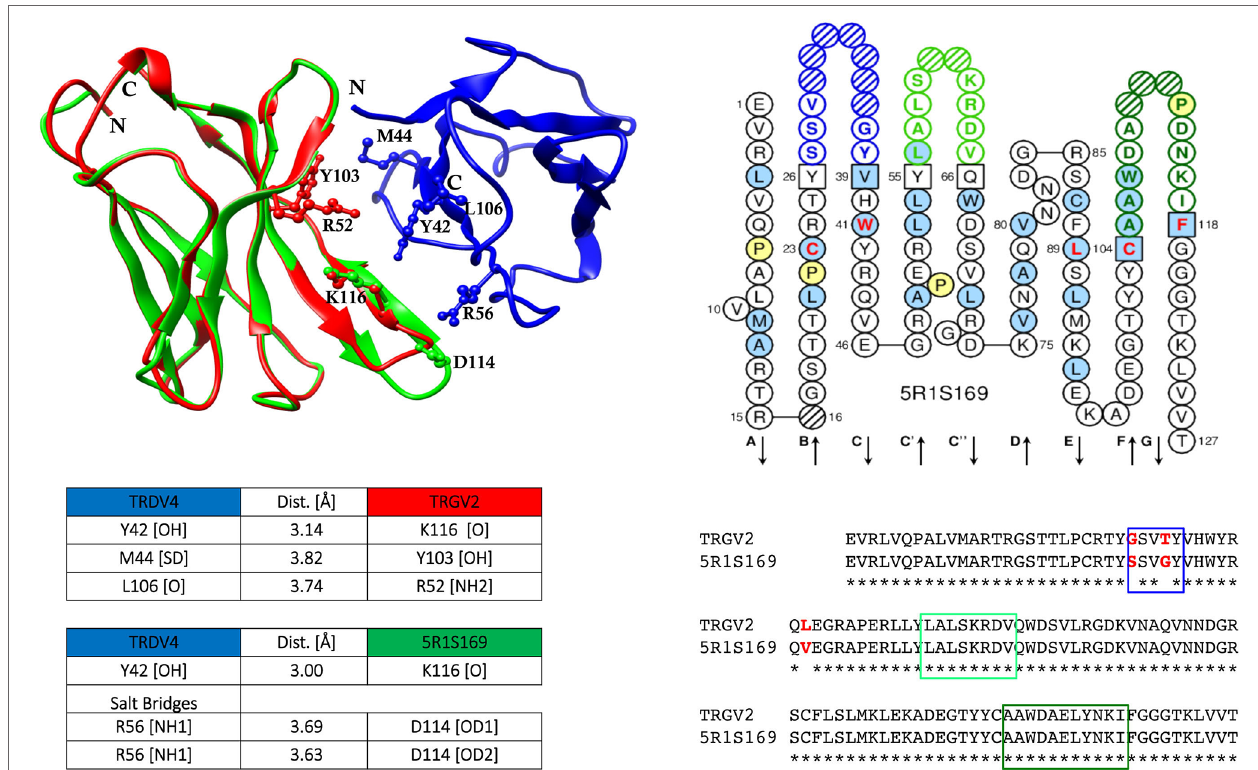
FIGURE 2 | Sequence comparison of dromedary TRGV2/5R1S169, and the computed interaction between the genomic TRGV2, its mutated counterpart 5R1S169, and the genomic TRDV4 (modified from Ciccarese et al., 2014). Structural overlapping of TRGV2 (depicted in red), and 5R1S169 clone (depicted in green) with TRDV4 (depicted in blue), is shown. CDR-IMGT regions are framed with colored rectangles according to IMGT standardized colors. IMGT Collier de Perles of 5R1S169 clone is shown (Lefranc et al., 2003; Lefranc, 2011a; Lefranc, 2011b). The protein complex interface was computed by the online tool PDBePISA at the EBI server. (http://www.ebi.ac.uk/msd-srv/prot_int/) and visualized by UCSF Chimera tool